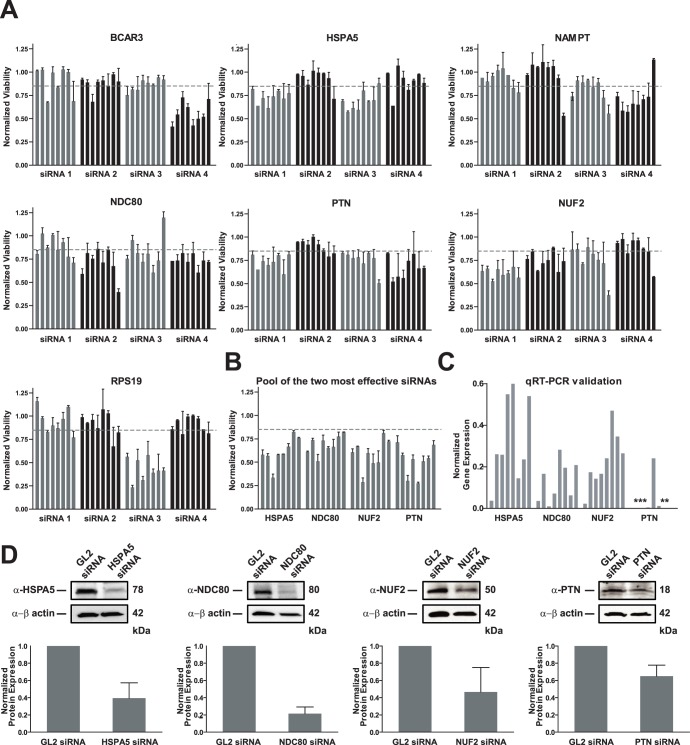
Validation of hits via siRNA deconvolution screening, qRT-PCR and Western blotting.
A. The seven hits selected for further studies were validated by performing deconvolution screens where individual siRNAs which were initially a part of a pool of four siRNAs in the secondary screens were evaluated for their effects on cell viability. For each hit being validated, the average normalized viability scores (±SD) following gene silencing using each of the four species of siRNAs evaluated in the eight EOC cell lines are shown. Hits were considered on-target if viability scores of less than 0.85 were observed for all eight EOC cell lines for at least two independent siRNA species targeting a gene. The bar graphs represent the eight EOC cell lines in the following order: A1847, A2780, C30, CP70, OVCAR5, OVCAR8, SKOV3, and UPN275. B. The two most effective siRNAs targeting each gene were pooled (12.5 nM each siRNA species) and the effect on cell viability was quantified. The bars represent the eight EOC cells lines as described in Panel A. C. qRT-PCR was performed on all of the eight EOC cell lines following gene silencing for 72 h using a pool of the two most effective siRNAs identified from the deconvolution studies from panel A for the four hits that were determined to be on target. The asterisk represents PTN mRNA levels which are below the level of detection following siRNA treatment (i.e. complete knockdown of mRNA). D. Western blot analysis was performed following gene silencing for either 72 h (HSPA5, NDC80, and PTN) or 120 h (NUF2) to determine the level of knockdown at the protein level in A1847 cells. Immuno blots were quantified using AlphaView software, version 3.3 (Cell Biosciences).